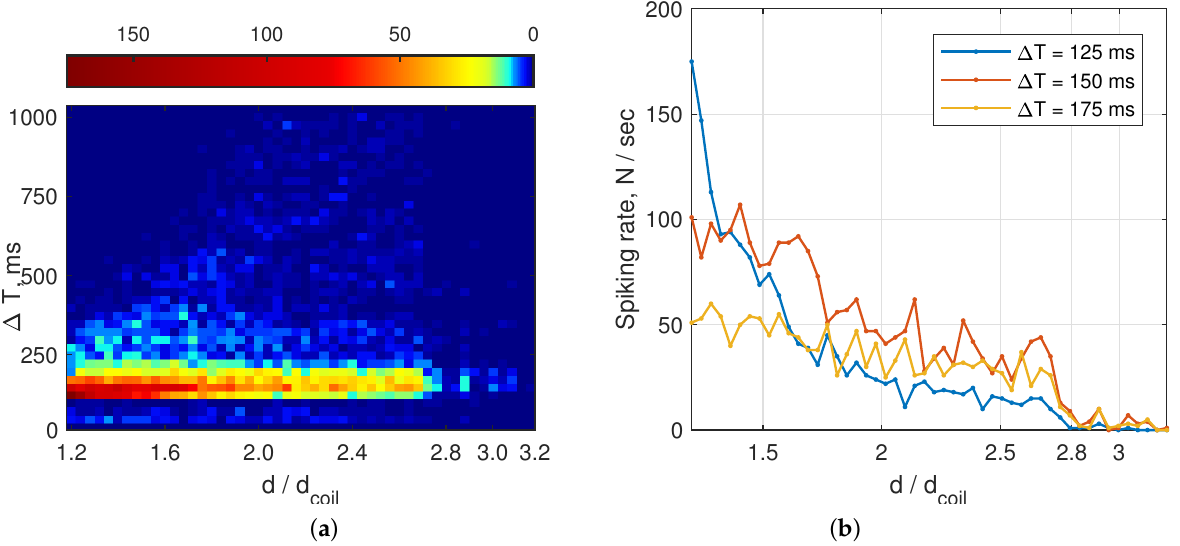
Figure 20. Spiking rate vs. distance between target (square brass plate 25 × 25 cm) and the closest coil: ( a ) interspike distribution diagram; and ( b ) the most intense spiking